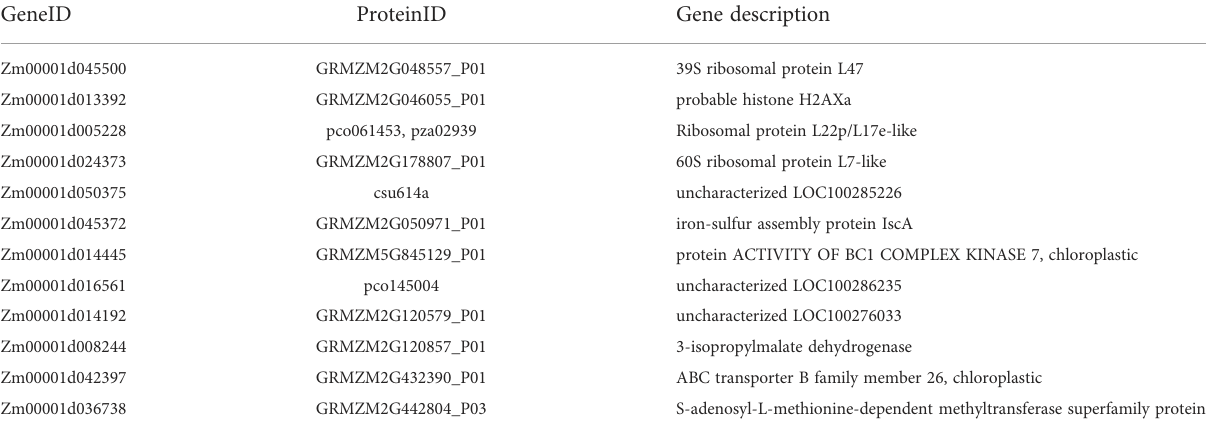
TABLE 4 The 12 hub genes of the protein-protein interaction network.